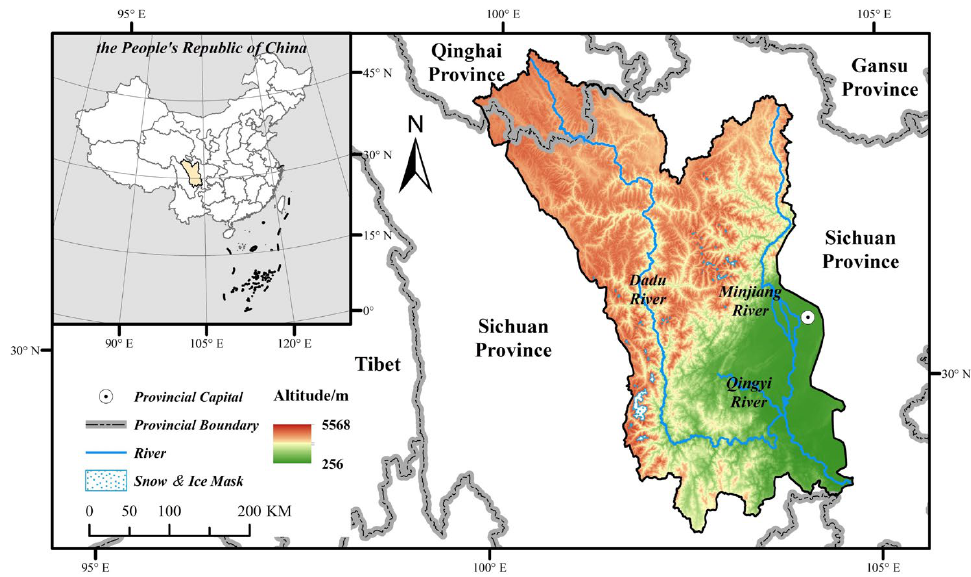
Figure 1. Location map of the Minjiang River Basin.